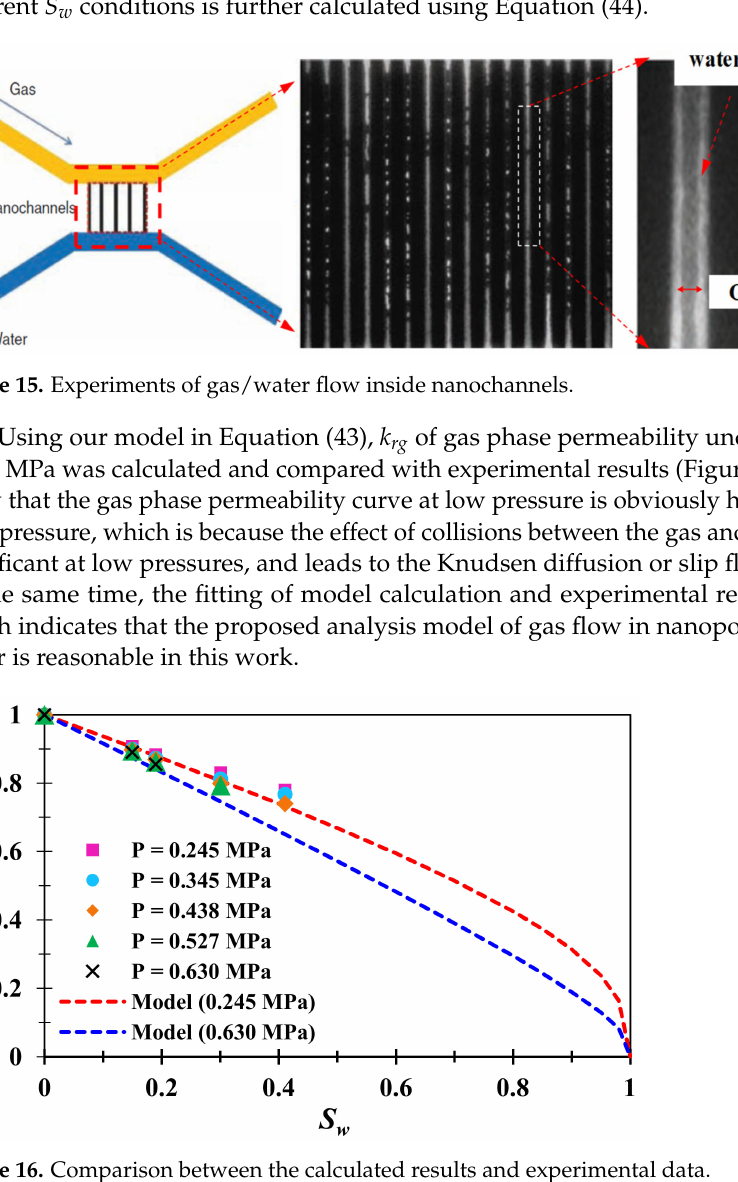
Figure 16. Comparison between the calculated results and experimental